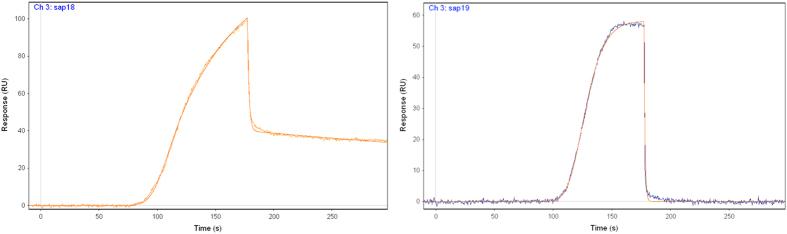
Representative data sets for kinetic analysis of sapogenin 18 and 19 in the interaction with PPARγ.Red lines represent the global fits of the data to a 1:1 bimolecular interaction model for 19 and a 2:1 model for 18. The kinetic parameters obtained from each interaction are reported in Table 1.